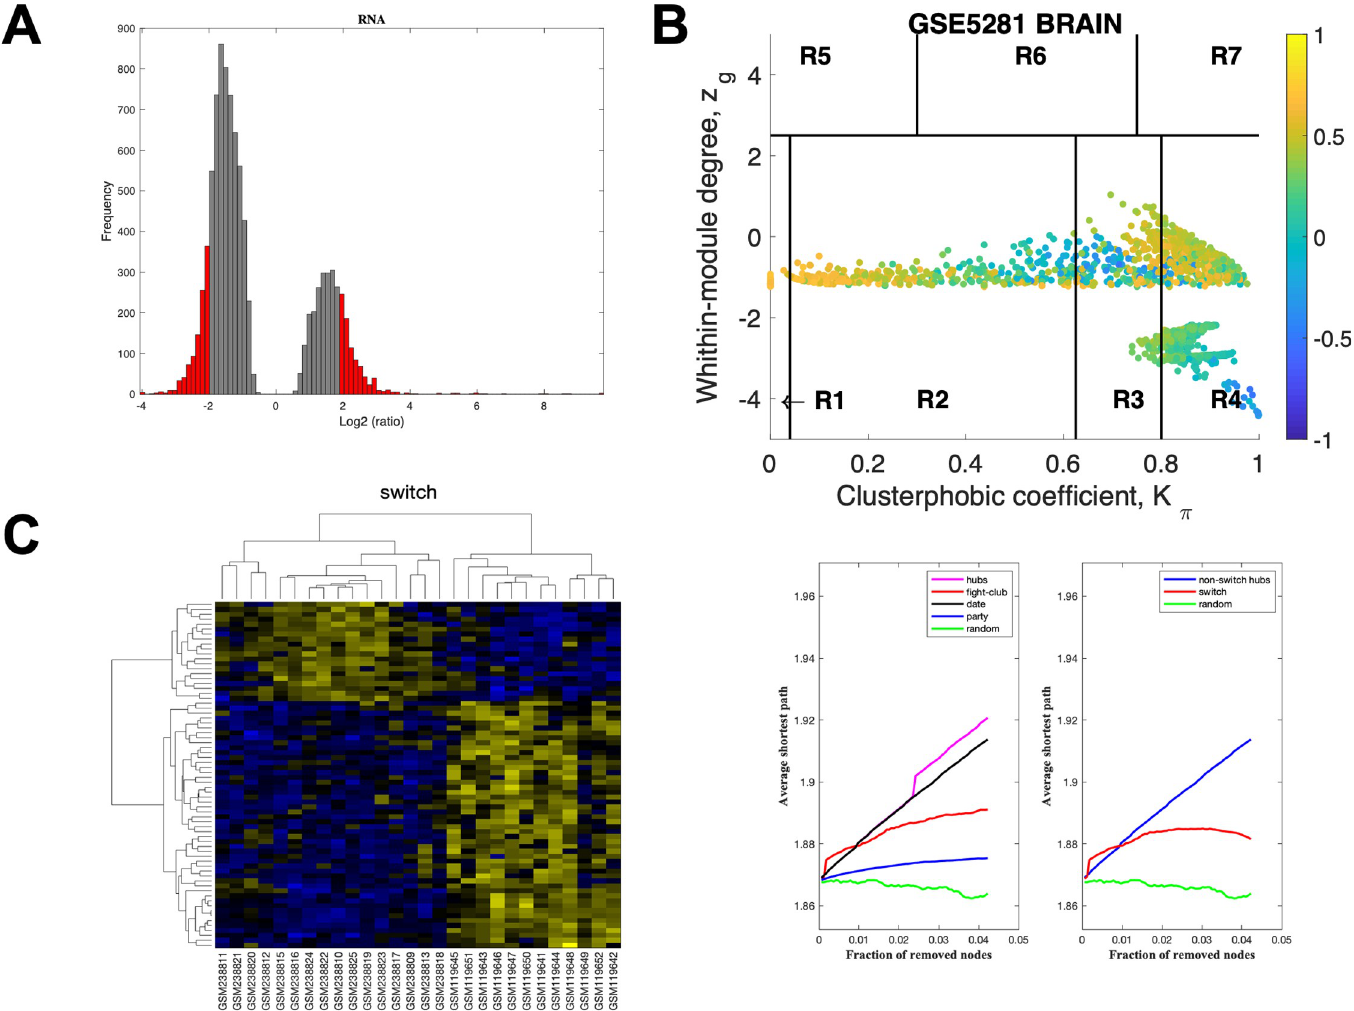
Fig 5. SWIM analysis of the mid temporal gyrus. A. Distribution of the fold-change values for GSE5281 brain microarray gene expression data from the MTG. The x- axis represents the fold-change value (log2 of the fold-change) that is the ratio of the average expression data in AD patients compared to the average expression data in normal controls computed for protein-coding and non-coding RNAs. The y-axis represents the frequency of the obtained fold-change values. The grey bars represent the fold-change values associated with protein-coding and non-coding RNAs that will be discarded according to the selected threshold. The red bars represent the fold-change values associated with protein-coding and non-coding RNAs that were retained for further analysis. B. Heat cartography map for GSE5281 brain data from the MTG. correlation network. The plane is identified by two parameters: Zg (within-module degree) and Kπ (clusterphobic coefficient) and it is divided into seven regions each defining a specific node role (R1-R7). High Zg values correspond to nodes that are hubs within their module (local hubs), whereas low Zg values correspond to nodes with few connections within their module (non-hubs within their communities, but they could be hubs in the network). Each node is colored according to its average Pearson Correlation coefficient (APCC) value. Yellow nodes are party and date hubs, which are positively correlated in expression with their interaction partners. Blue nodes are the fight-club hubs, which have an average negative correlation in expression with their interaction partners. Blue nodes falling in the region R4 are the switch genes, which are characterized by low Zg and by high Kπ values and are connected mainly outside their module. C. Dendrogram and heat map for switch genes in GSE5281 brain microarray gene expression data from the MTG. The expression profiles of switch genes (including protein-coding and non-coding RNAs) are clustered according to rows (switch genes) and columns (samples) of the switch genes expression data (biclustering). The colors represent different expression levels that increase from blue to yellow. The red line under the x axis labels denotes AD samples. D. Robustness for the GSE5281 brain correlation network from the MTG. The x-axis represents the cumulative fraction of removed nodes, while the y-axis represents the average shortest path. The shortest path between two nodes is the minimum number of consecutive edges connecting them. Each curve corresponds to the variation of the average shortest path of the correlation network as function of the removal of nodes specified by the colors of each